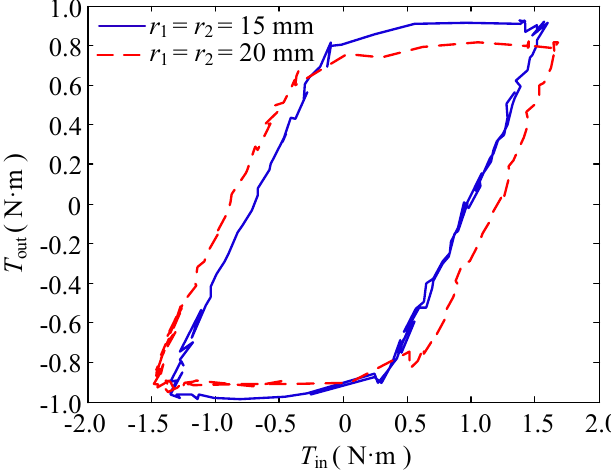
Figure 7. Torque transfer relationship when the radius of the pulley changes.